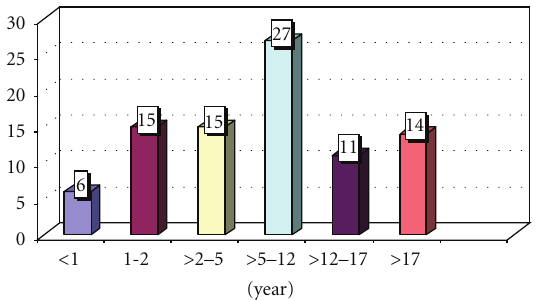
Figure 2: Age distribution of the patients at